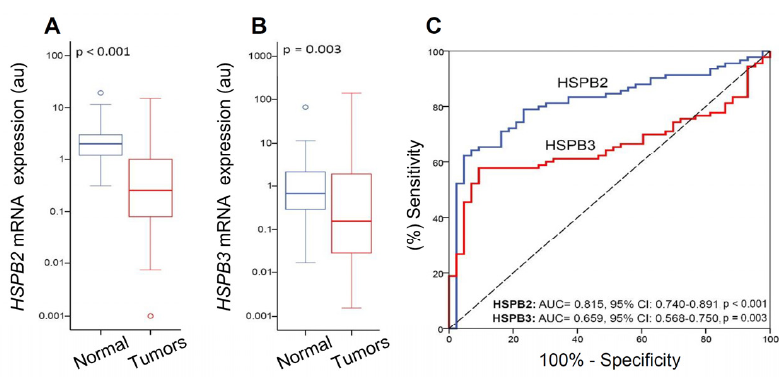
Figure 2. ( A , B ) Comparison of HSPB2 ( A ) and HSPB3 ( B ) mRNA expression levels in BlCa specimens vs. normal urothelium. p -value was calculated using the Mann–Whitney U test. ( C ) ROC curve analysis of HSPB2 and HSPB3 genes expression levels’ ability to discriminate bladder tumors from normal urothelium. The middle lines inside the boxes indicate the median (50th percentile or second quartile), while the lower and the upper box boundaries represent the 25th percentile (first quartile) and the 75th percentile (third quartile), respectively. The lower and upper whisker extend to the lowest and highest value, respectively, within the 1.5 × interquartile range (box height) from the box boundaries. p -value was calculated by the Hanley and McNeil method.